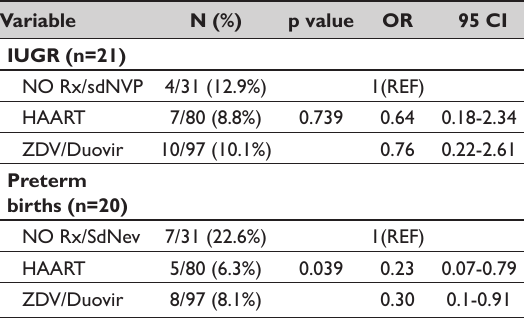
Table 4: Effect of ART on PTB and